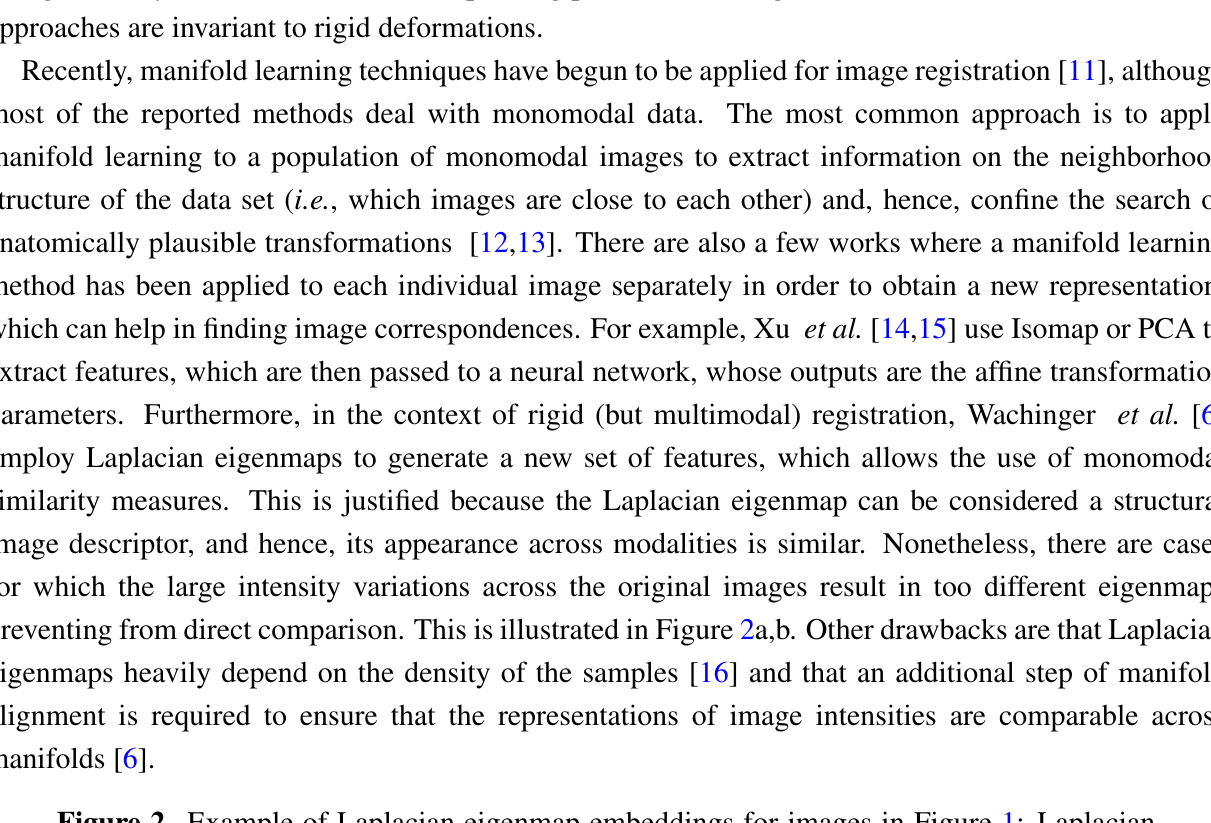
Figure 2. Example of Laplacian eigenmap embeddings for images in Figure 1: Laplacian images for T1 ( a ) and for T2 ( b ). They were obtained by taking the first eigenvector of the graph Laplacian of the original